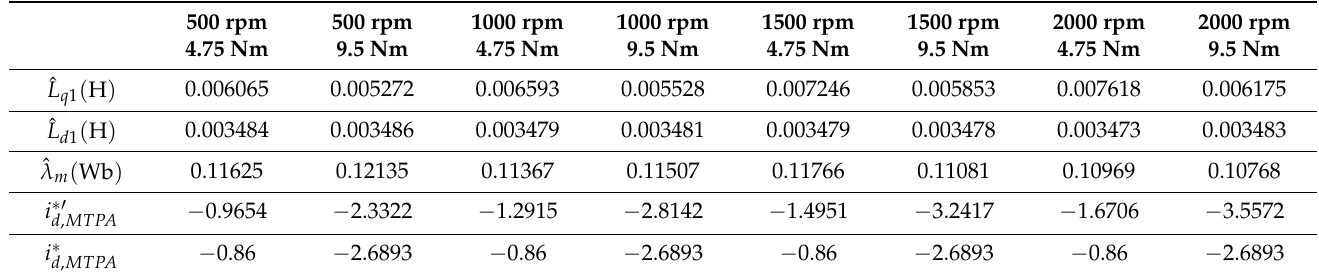
Figure 8. Experimental results of finding the lowest stator current: ( a ) at 500 rpm with 4.75 Nm; ( b ) at 2000 rpm with 9.5 Nm. Table 3. Estimated ˆ L q 1 , ˆ L d 1 , ˆ λ m and i ∗(cid:48) using initial L d 0 with i ∗ d , MTPA d , MTPA